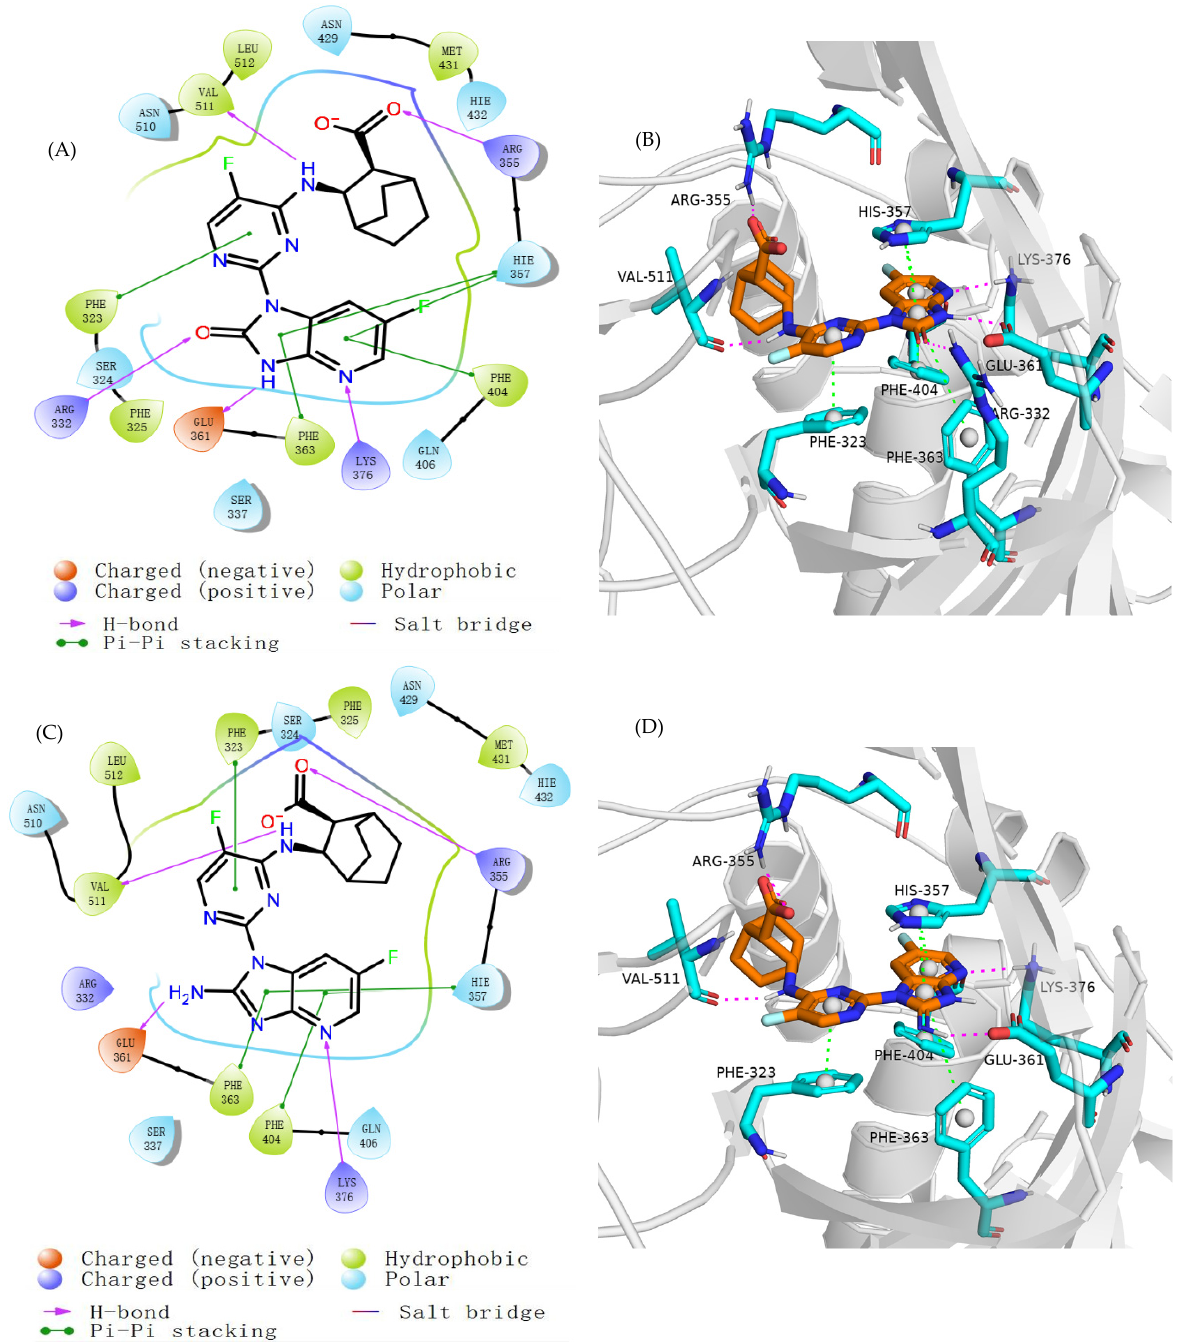
Figure 3. The 2D representation ( A ) and 3D summary ( B ) of the interaction analysis results of the PB2/comp. I protein complex. Proposed binding models of comp. II with PB2 protein shown as a 2D conformation ( C ) and 3D summary ( D ). The π – π stacking interaction is shown as a green dashed line, the intermolecular hydrogen bond as a magenta dashed line, and the salt bridge as a blue dashed line.